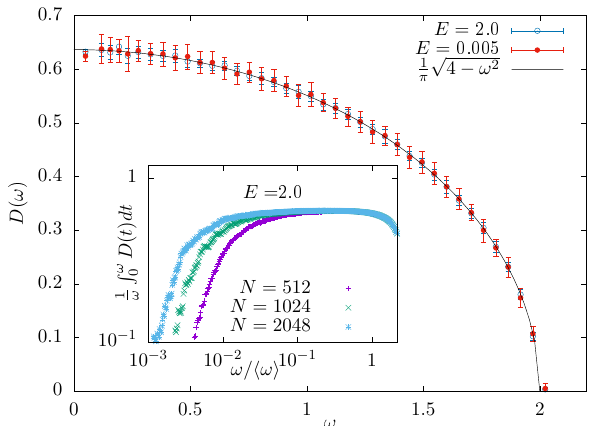
Figure 10: Density of states of the linear perceptron optimization problem for two values of the energy at fixed α = 5 (at energy E = 2 averaged over 30 samples with system size N = 2048, at energy E = 0.005 averaged over 50 samples with system size N = 1024). The black line is the theoretical prediction given by Eq. (10). In the Inset we plot the left tail of the DOS for different sizes which shows that the behavior is compatible with having a positive DOS for ω →